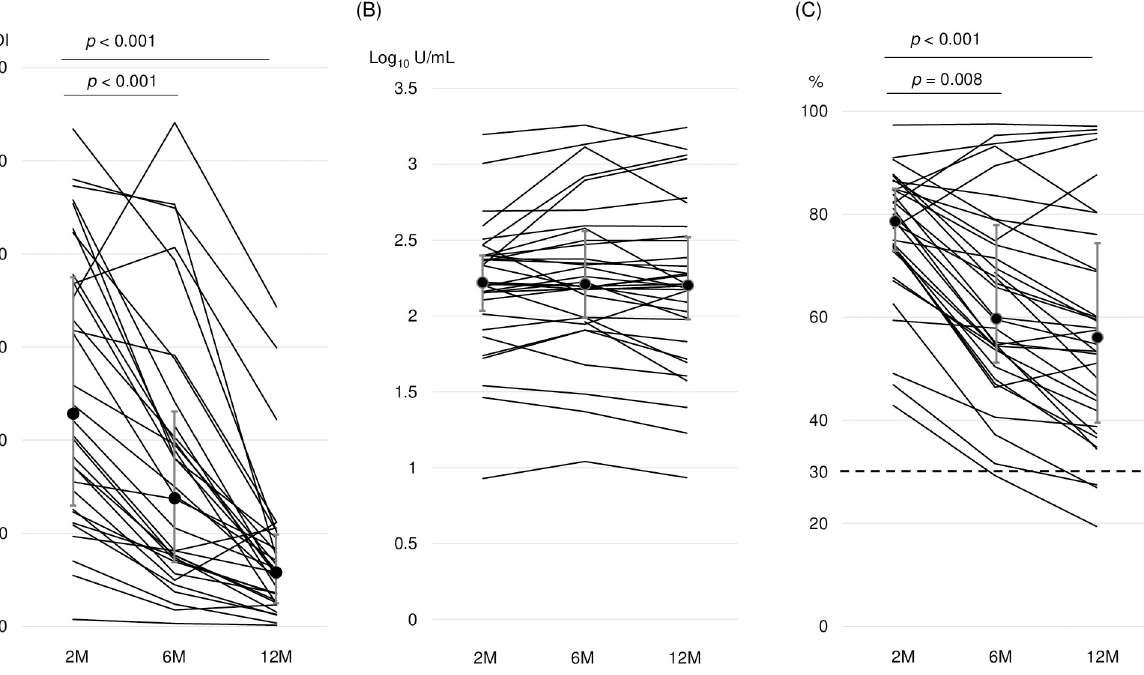
Fig 1. The changes of antibody responses from 2M, 6M, to 12M after the outbreaks of COVID-19 at workplaces among 33 with asymptomatic, mild to moderate COVID-19. (A) The changes of the anti-nucleocapsid antibody. Cutoff index (COI) ≧ 1.0 is positive. (B) The changes of the anti- receptor-binding domain antibody. The numeric value � 0.8 U/mL [Log 10 (0.8) = –0.0969] is positive. (C) The changes of the inhibition rate of antibody specific to the receptor-binding domain that is equivalent to neutralizing antibody. The positive cutoff is ≧ 30%, indicated as the dotted line. Significance among three points was analyzed by the Friedman test and post hoc analysis with a Bonferroni correction. The dot and error bars correspond to the median for anti-nucleocapsid antibody and anti-receptor-binding domain and the median titer for inhibition rate of neutralizing antibody ± interquartile